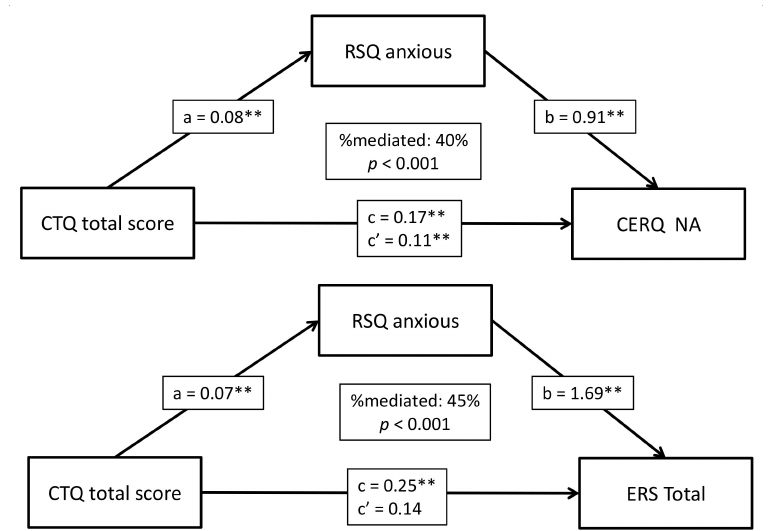
Figure 1. Mediation analyses in the whole population showing the effect of childhood maltreatment (CTQ total score) on CERQ non-adaptive strategies and ERS total score, mediated by anxious attachment (RSQ anxious). c: total effect of CTQ total score on outcomes (ab + c’); c’: direct effect of CTQ total score on outcomes; a: effect of the independent variable on the mediator; b: effect of the mediator on the dependent variable. ** p <